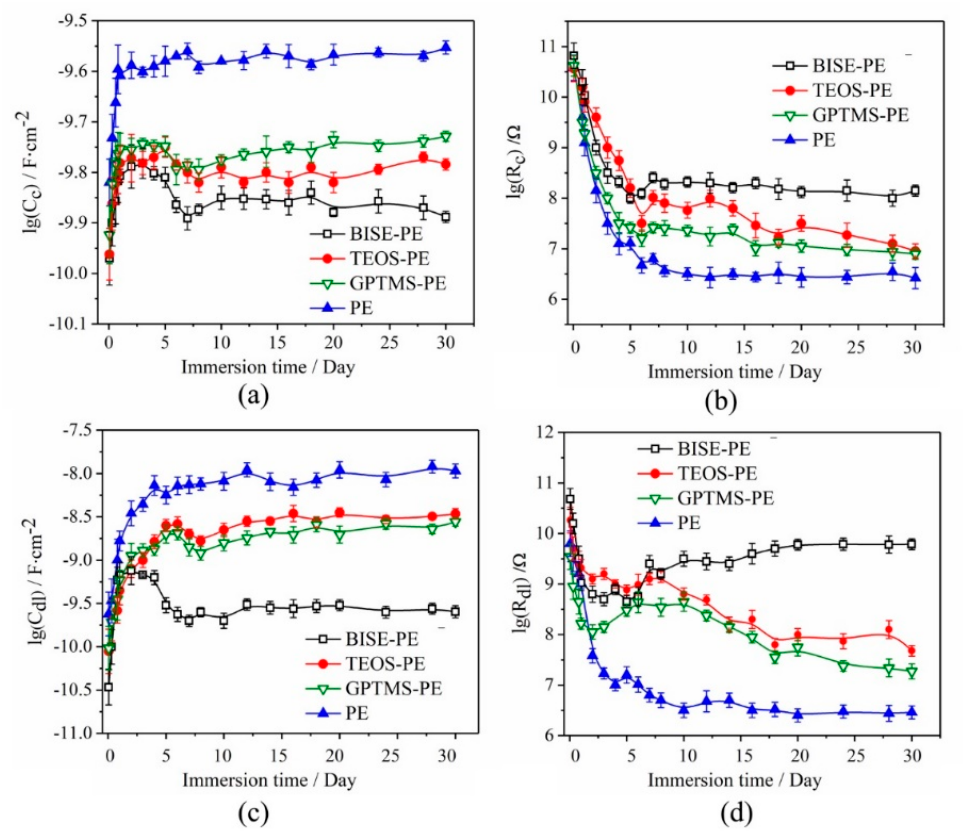
Figure 5. Evolution of the electrical parameters: ( a ) C c , ( b ) R c , ( c ) C dl , and ( d ) R dl , derived from EIS data.